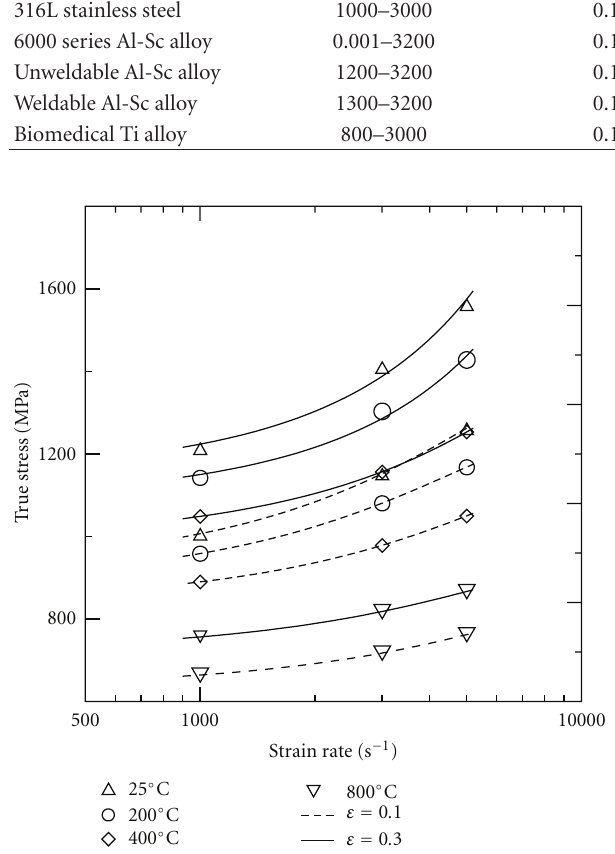
Figure 5: Variation of true stress with strain rate as function of temperature at true strains of 0.1 and